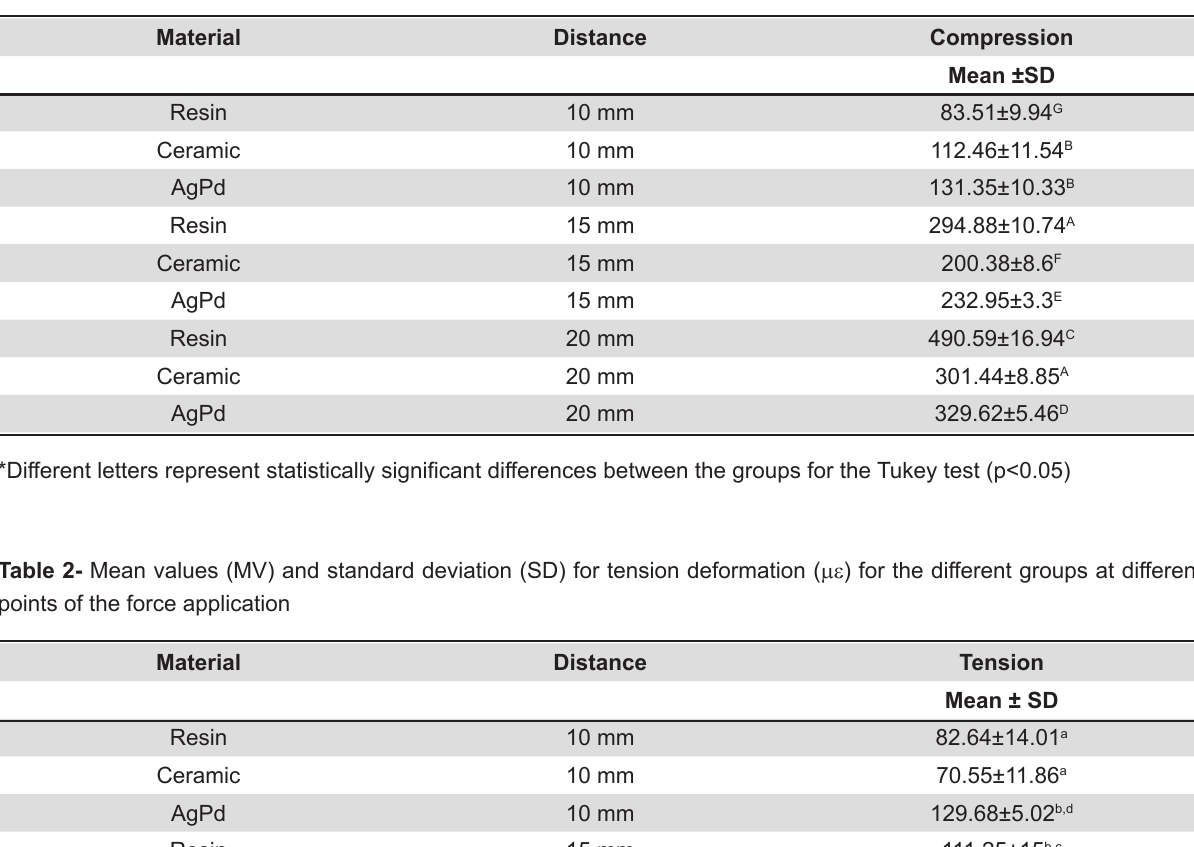
Table 1- Mean values (MV) and standard deviation (SD) for compression deformation ( me ) for the different groups at different points of the force application